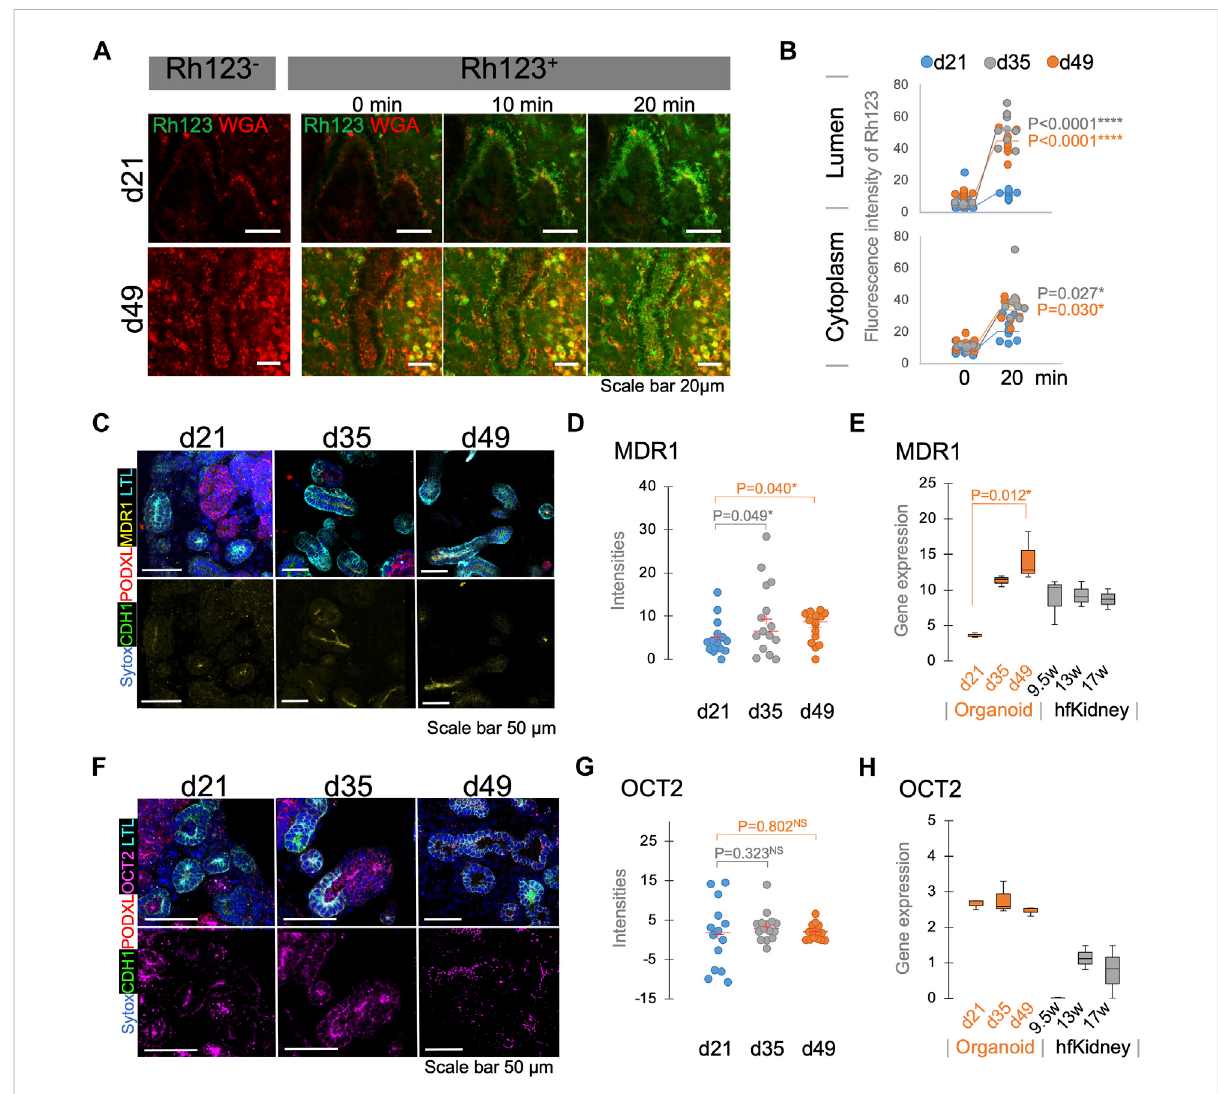
FIGURE 5 Functional maturation assessed by live functional assay, immunostaining, and RNA-seq in kidney organoids. (A) Rh123 transport in proximal tubules of kidney organoids between d21 and d49. Organoids at d49 show prominent luminal accumulation which is later (B) con fi rmed by quanti fi cation between 0 and 20 min time points. (C) Immunostaining validates that MDR1 expression on d35/49 is greater than on the d21. MDR1 expression is localized to the apical membrane of the proximal tubules. (D) Quanti fi cation of MDR1 staining con fi rms a signi fi cant increaseinMDR1expressionond35/49 n =15. (E) RNA-seqforMDR1inkidneyorganoidsandhumanfetalkidneys(hfKidney). (F) Immunostainingfor OCT2 ind21,d35,andd49kidney organoids. (G) Quanti fi cationofOCT2 stainingshowsstableexpressionfromd21. n =15. (H) RNA-seqforOCT2 in kidney organoids and hfKidney. n = 3 for organoid samples and 2 for